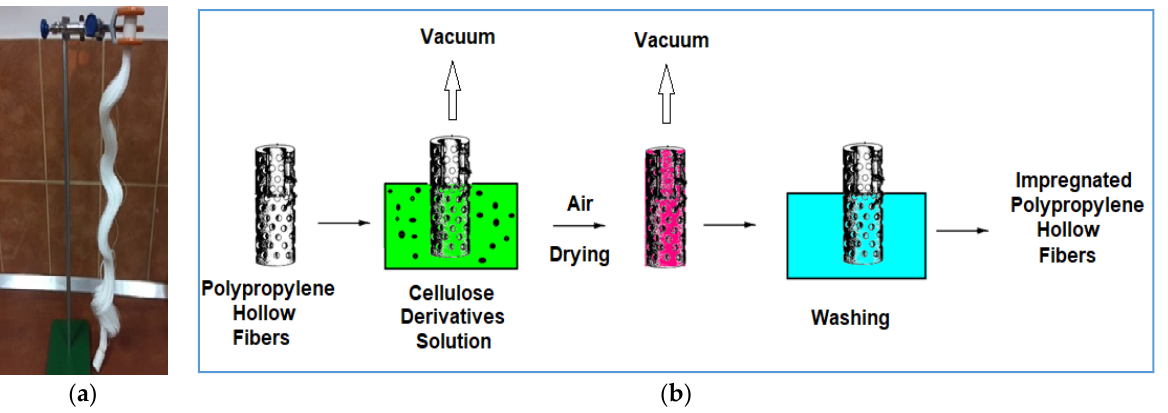
Figure 3. Schematic depiction of the impregnation procedure: ( a ) hollow polypropylene fiber bundles; and ( b ) scheme of the stages of the impregnation procedure.